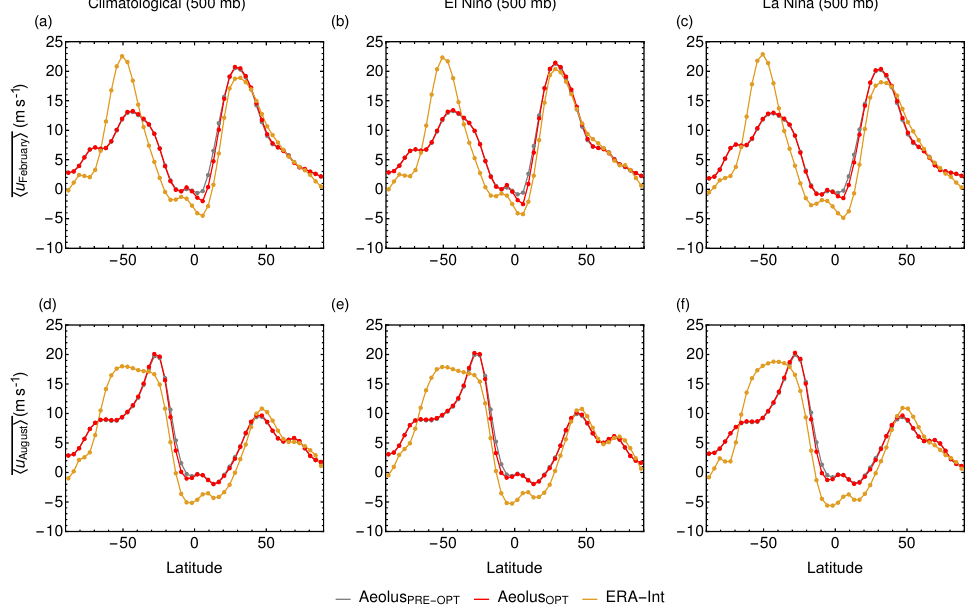
Figure 5. Zonal-mean large-scale zonal wind velocity (cid:104) u(z,φ) (cid:105) at 500mb. Panel (a) shows the climatological monthly mean zonal-mean zonal velocity in February, (b) the monthly mean zonal-mean velocity of El Niño February months and (c) the monthly mean zonal-mean velocity of La Niña February months. Panel (d) displays the monthly mean climatological zonal-mean zonal velocity in August, (e) the monthly mean zonal-mean velocity in El Niño August months and (f) the monthly mean zonal-mean velocity in La Niña August months. The yellow line represents zonal-mean large-scale zonal wind obtained by reanalysis data, the gray line is zonal-mean large-scale zonal wind velocity from Aeolus using pre-optimized parameters and the red line represents zonal-mean large-scale zonal wind velocity from Aeolus using optimized